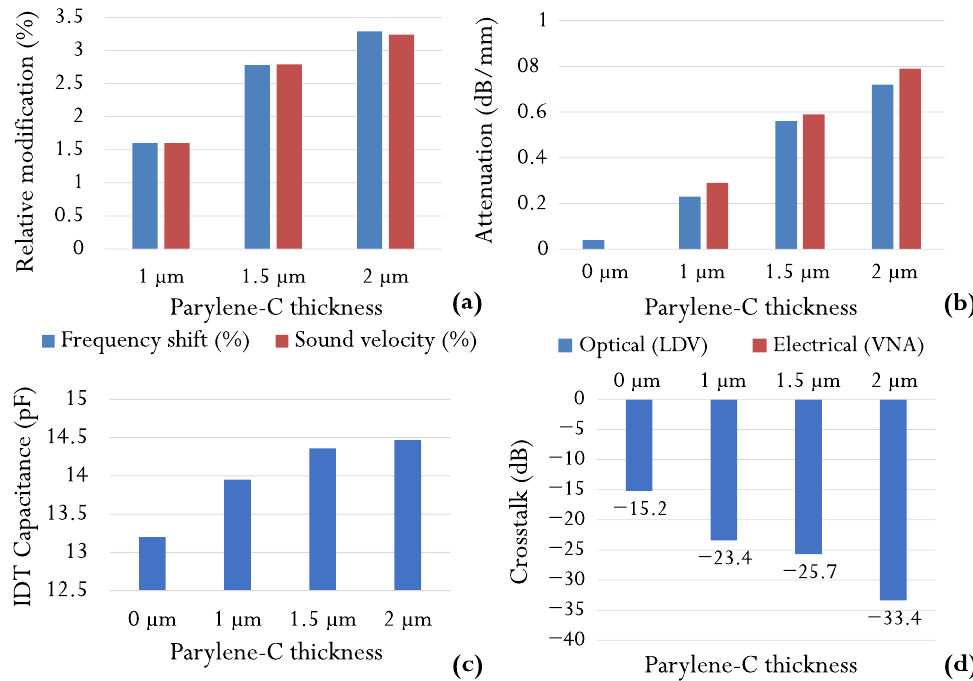
Figure 7. Various sensor characteristics vs. parylene coating thickness: frequency shift and sound velocity variation ( a ); attenuation ( b ); IDT capacitance ( c ); crosstalk ( d